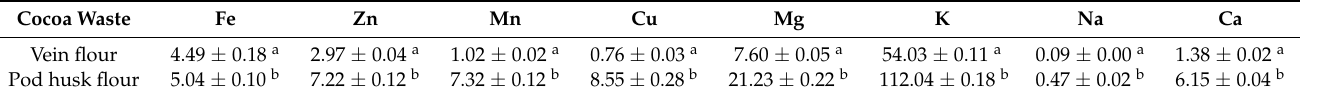
Table 3. Mineral content (mg/100 g) in flour from vein and pod husk of cocoa